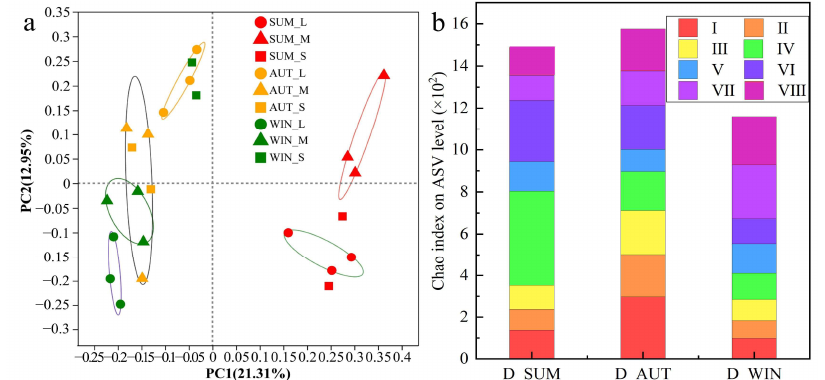
Figure 7. Size distributions of bacterial aerosols in three seasons. ( a ) PCoA based on the unweighted UniFrac distance matrix for aerosol samples collected from the AT of the three seasons. ( b ) Chao values at eight size stages. SUM: summer; AUT: autumn; WIN: winter. Round: large particles (L); Triangles: medium particles (M); Square: small particles (S).